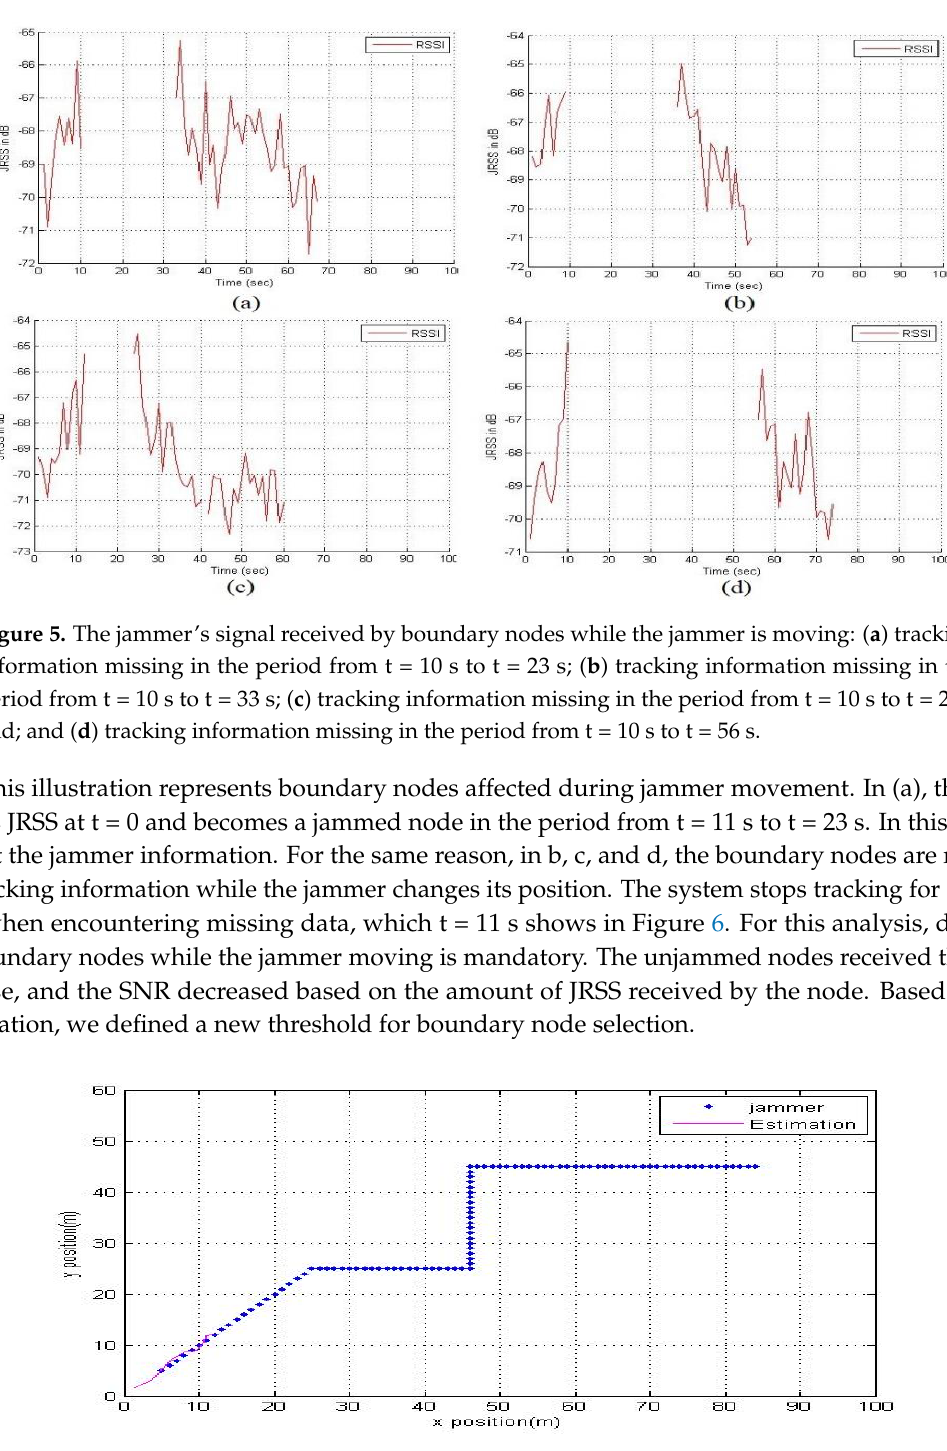
The red star is the jammer, the yellow circles represent the jammed nodes, green circles are the boundary nodes, and the blue circle denotes the boundary nodes’ neighbors. The red arrow is the JRSS received by the boundary node, and the dotted line is the bidirectional link between nodes. It is clear that the nodes located outside the jamming region are affected by JRSS. When the jammer is moving, the status of the node changes from unjammed to jammed, or a jammed node becomes an isolated node, as shown in Figure 5.